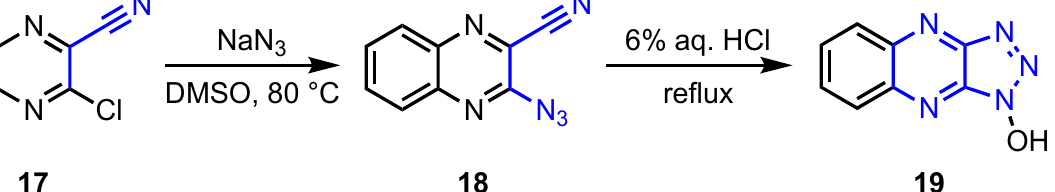
Scheme 2. Conversion of 2-chloro-3-cyanoquinoxaline 17 to 2-azido-3-cyanoquinoxaline 18 and benzo-fused 1 H -1,2,3-triazolo[4,5- b ]pyrazine 19 .